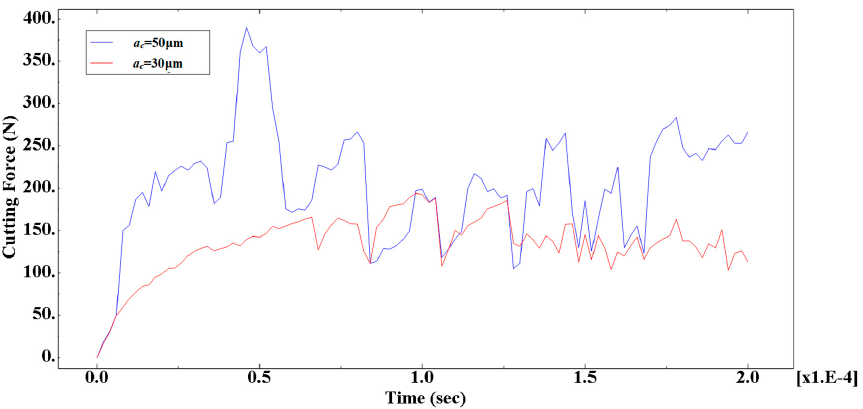
Figure 25. Comparison of stress distribution in different thickness calculations: (a) a c = 30 μ m, (b) a c = 50 μ m.